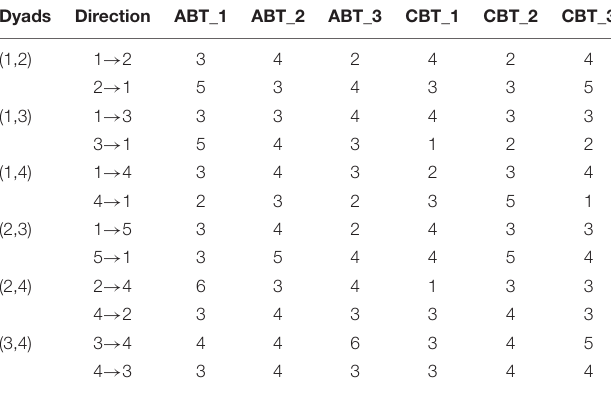
TABLE 1 | An illustrative portion of the interpersonal trust survey